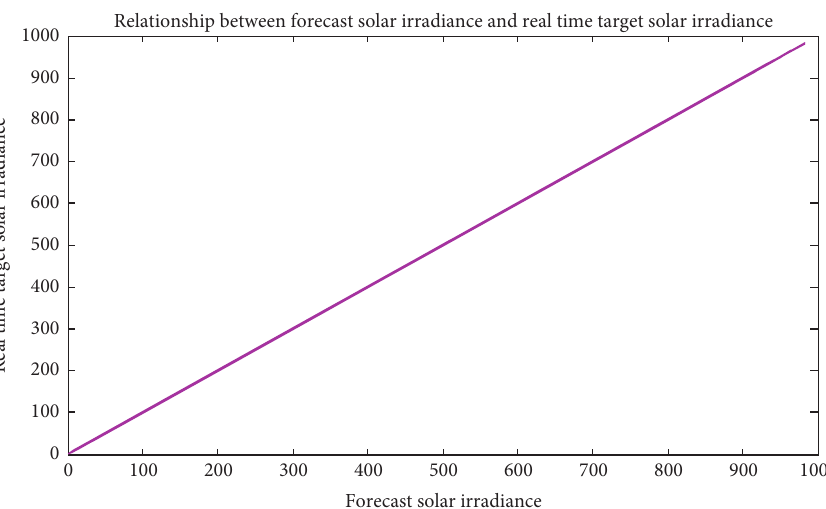
Figure 9: Relationship between forecast solar irradiance and real-time target solar